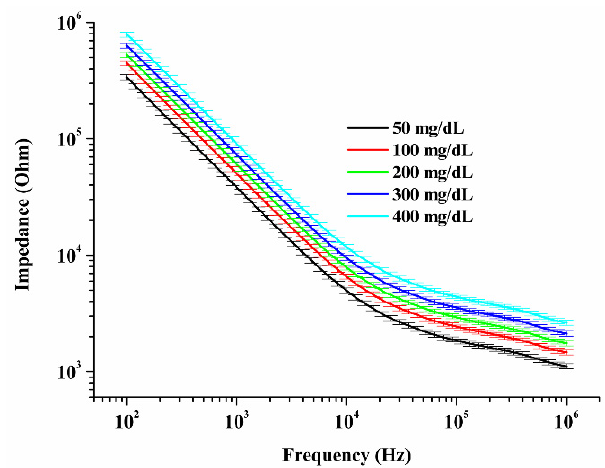
Fig. 5: A typical representation of Bode plot for different glucose concentrations with error bars.